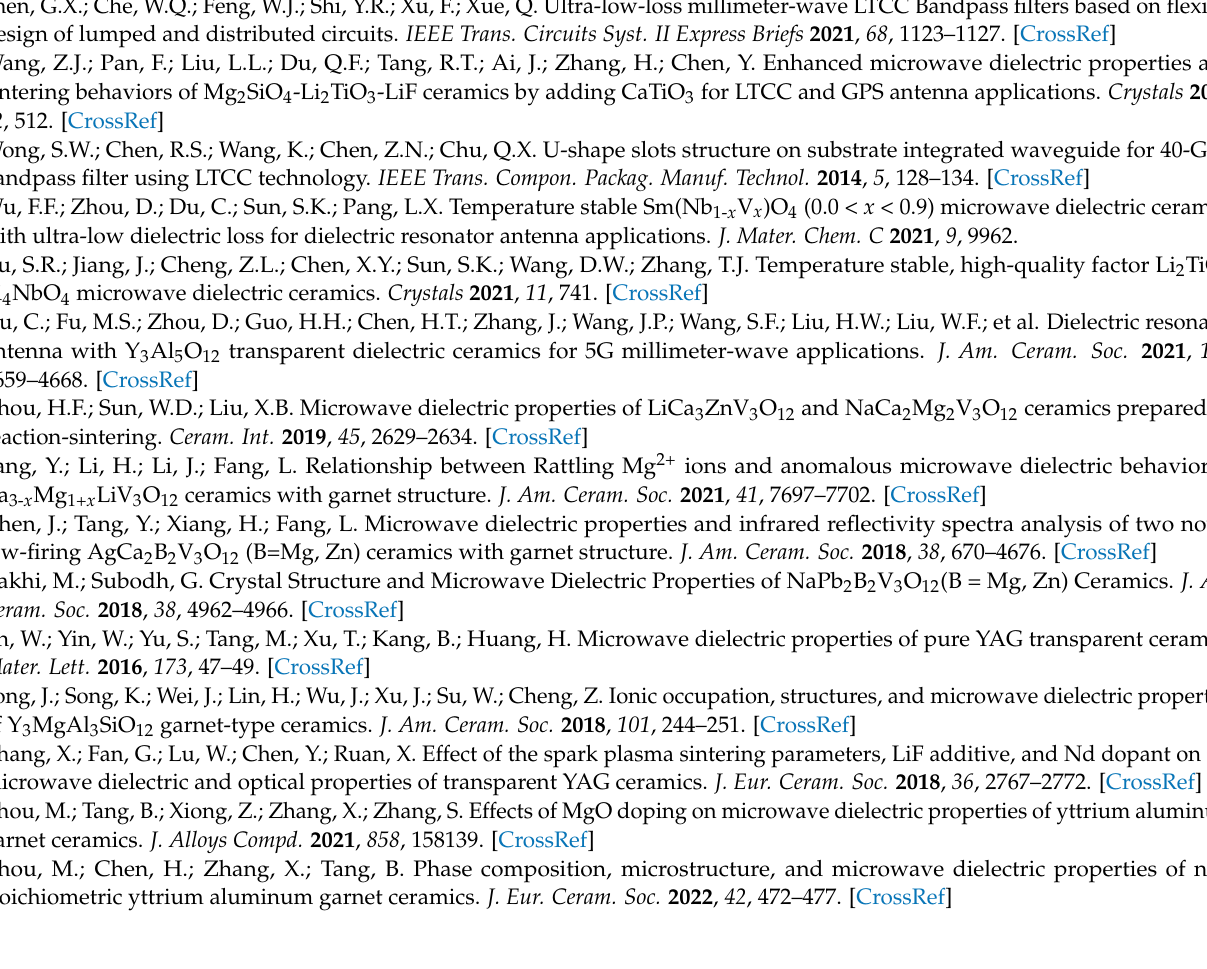
Table S2: The lattice energy U (kJ/mol) of Y 2.95 R 0.05 MgAl 3 SiO 12 ceramics; Table S3: The bond energy ceramics; Table S5: The Phonon parameters obtained from the fitting of the infrared reflectivity spectra of Y 2.95 Dy 0.05 MgAl 3 SiO 12